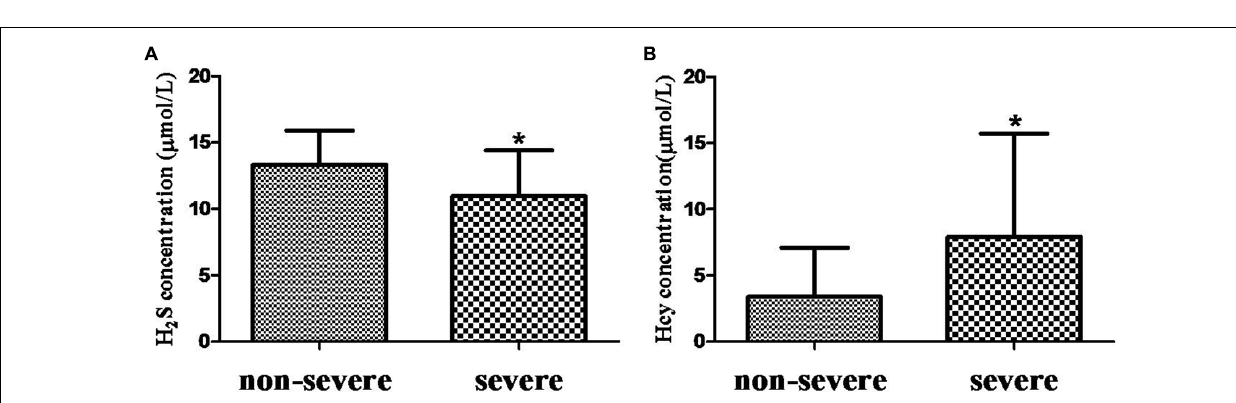
FIGURE 2 | The H 2 S and Hcy in non-severe and severe groups. (A) Serum H 2 S concentration in both groups; (B) Serum Hcy concentration in both groups. The data are described as mean ± SD. ∗ P < 0.05 versus